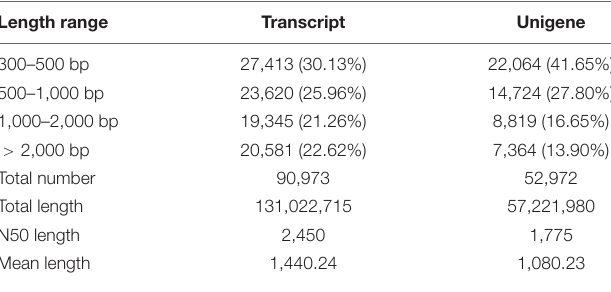
TABLE 3 | Statistical results of transcripts and